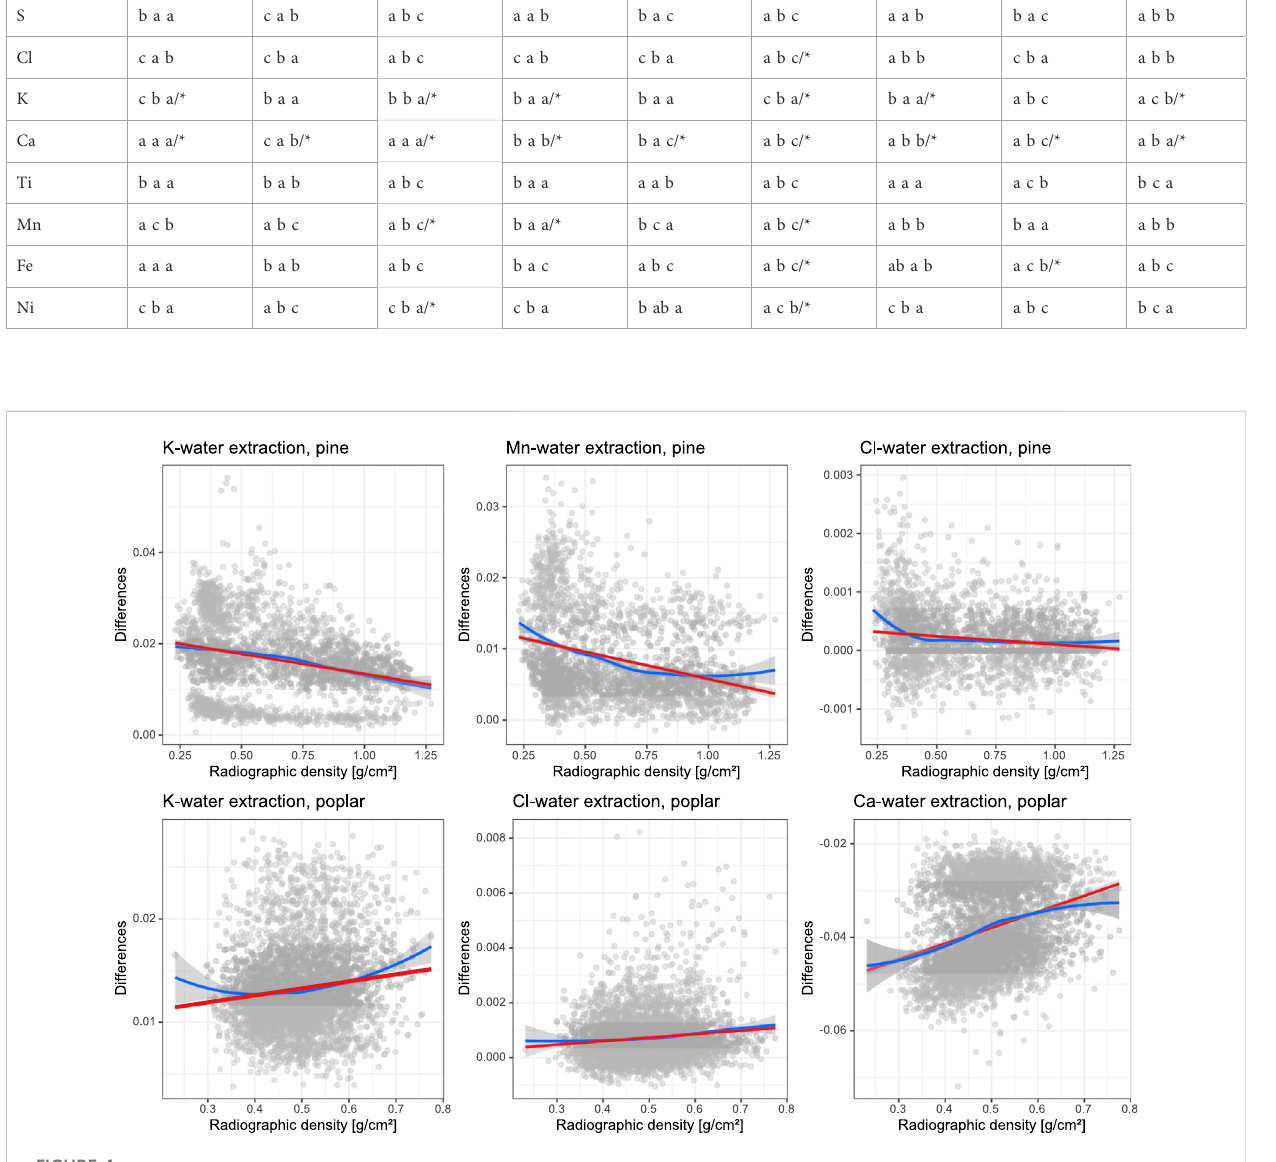
FIGURE 4 Relationship between wood density and extraction intensity for selected elements in the pine (upper row) and poplar samples (lower row); plotted are the differences values in countrates between control and the 24 h water extraction for K, Mn, and Cl (pine) and K, Cl, and Ca (poplar). Linear models (red lines) are signi fi cant ( p < 0.01, Supplementary Table S3), a smoothing line is also plotted (blue line). Note the opposite slopes with decreasing extractionsuccesswithincreasingdensitiesforpinesamples(negativeslopes)andincreasingextractionintensitywithincreasingdensitiesforpoplar (positive